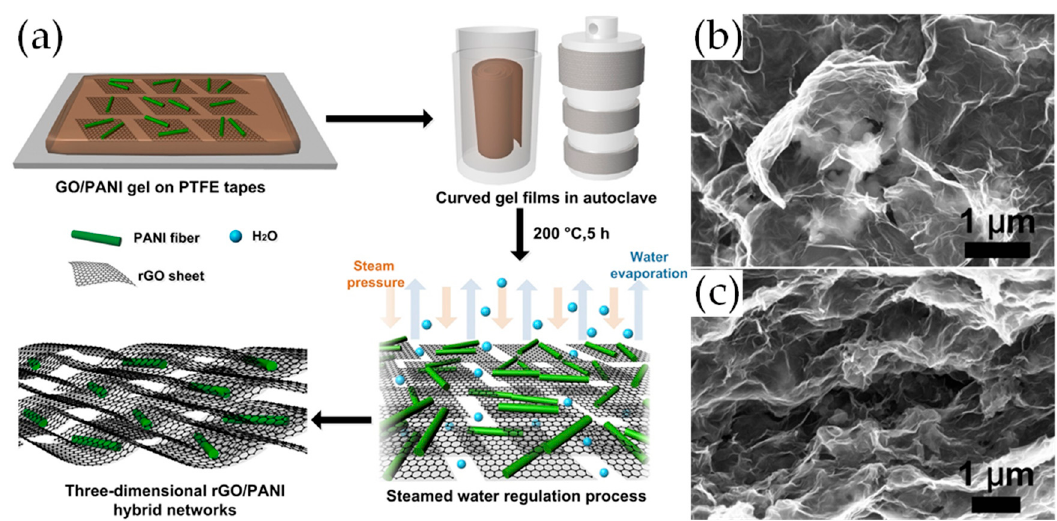
Figure 4. ( a ) Schematic illustration of rGO/PANI hybrid films by steamed water regulation techniques; ( b ) FE-SEM images of rGO/PANI (50%) hybrid films; ( c ) Cross-section FE-SEM images of rGO/PANI (50%) hybrid films. Reproduced with permission from [54]. Elsevier (2017).